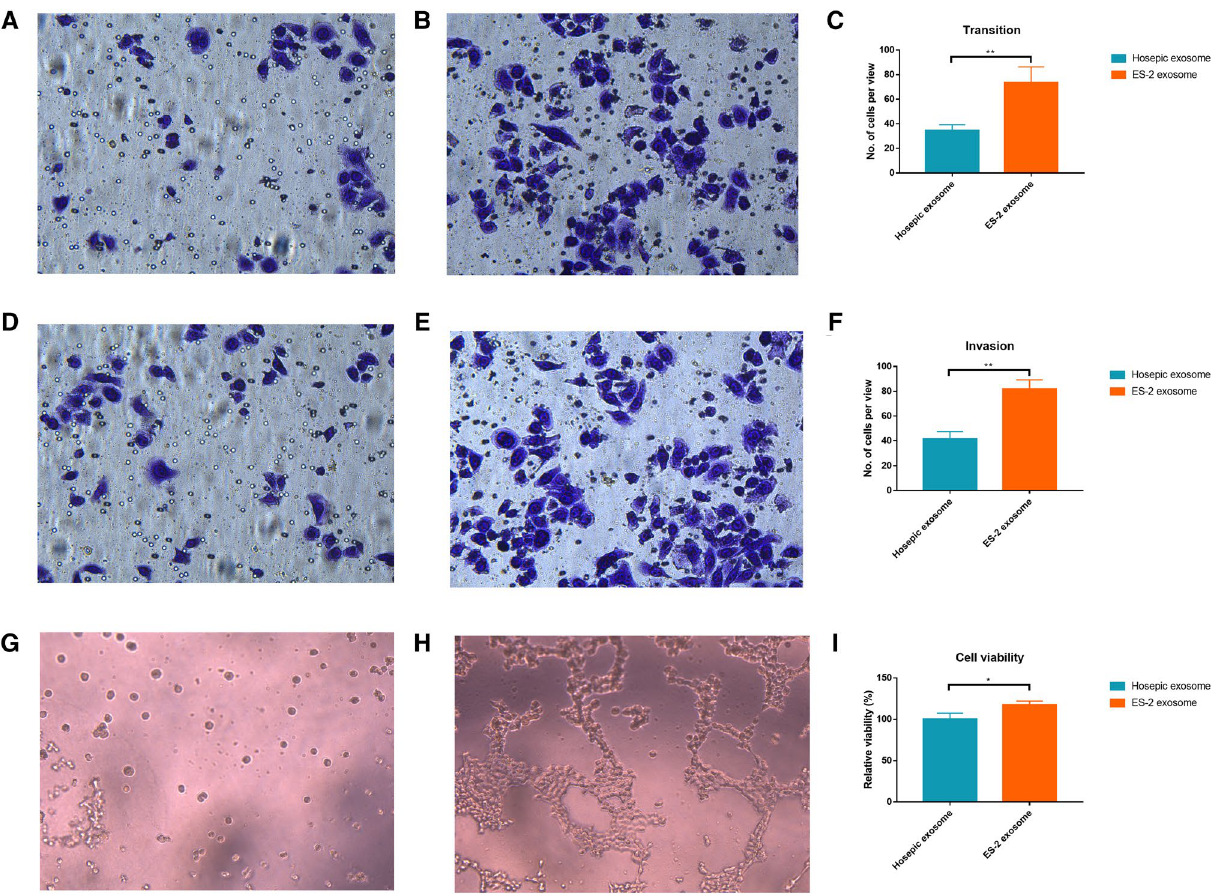
Fig. 2 The effect of EVs on cell migration, invasion and angiogenesis. A Transition study of Hosepic EVs on Hosepic cells. B Transition study of ES-2 EVs on Hosepic cells. C Comparison of number of cells per view in transition study. D Invasion study of Hosepic EVs on Hosepic cells. E Invasion study of ES-2 EVs on Hosepic cells. F Comparison of number of cells per view in invasion study. G Angiogenesis study of Hosepic EVs on Hosepic cells. H Angiogenesis study of ES-2 EVs on Hosepic cells. I Cell viability assay of Hosepic and ES-2 EVs on Hosepic